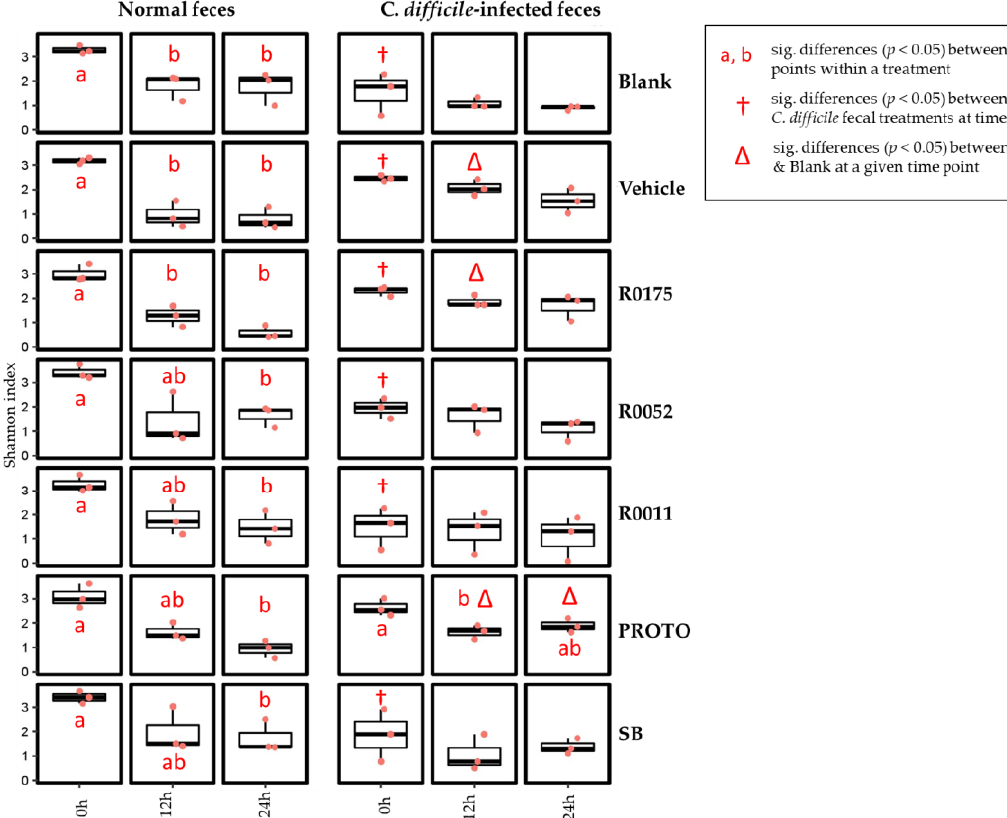
Figure 6. Microbial alpha diversity in normal and Clostridium ( C. ) difficile -infected feces assessed by the Shannon index. The symbol † represents significant (sig.) differences ( p < 0.05) between feces for a particular treatment at time 0 h. The symbol ∆ represents significant differences ( p < 0.05) between treatment at a particular time point and blank at the corresponding time point. Means at time points within treatments without a common letter are significantly different ( p < 0.05). R0011 = L. rhamnosus R0011; R0052 = L. helveticus R0052; SB = S. boulardii CNCM I-1079; R0175 = B. longum R0175; PROTO = ProtecFlor TM .